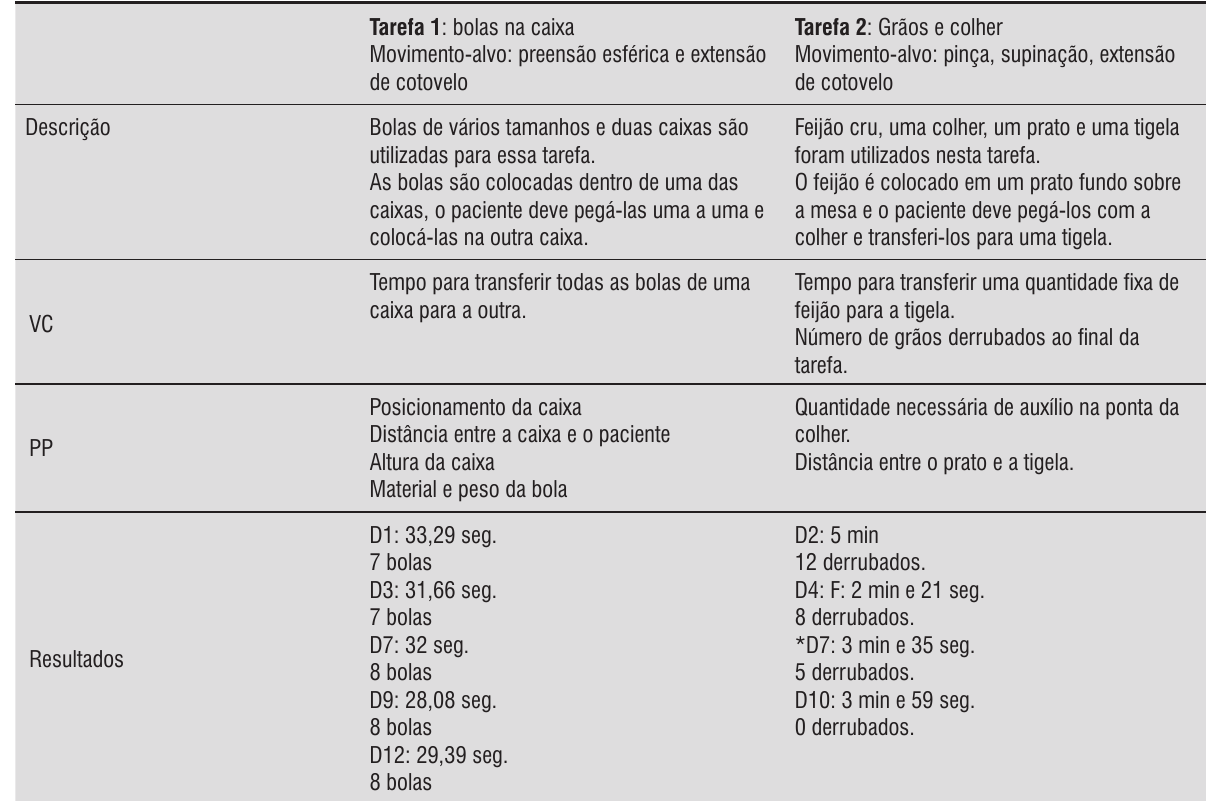
As tabelas 1 e 2 apresentam os resultados de tem- po e da EHF obtidos pelo WMFT respectivamente